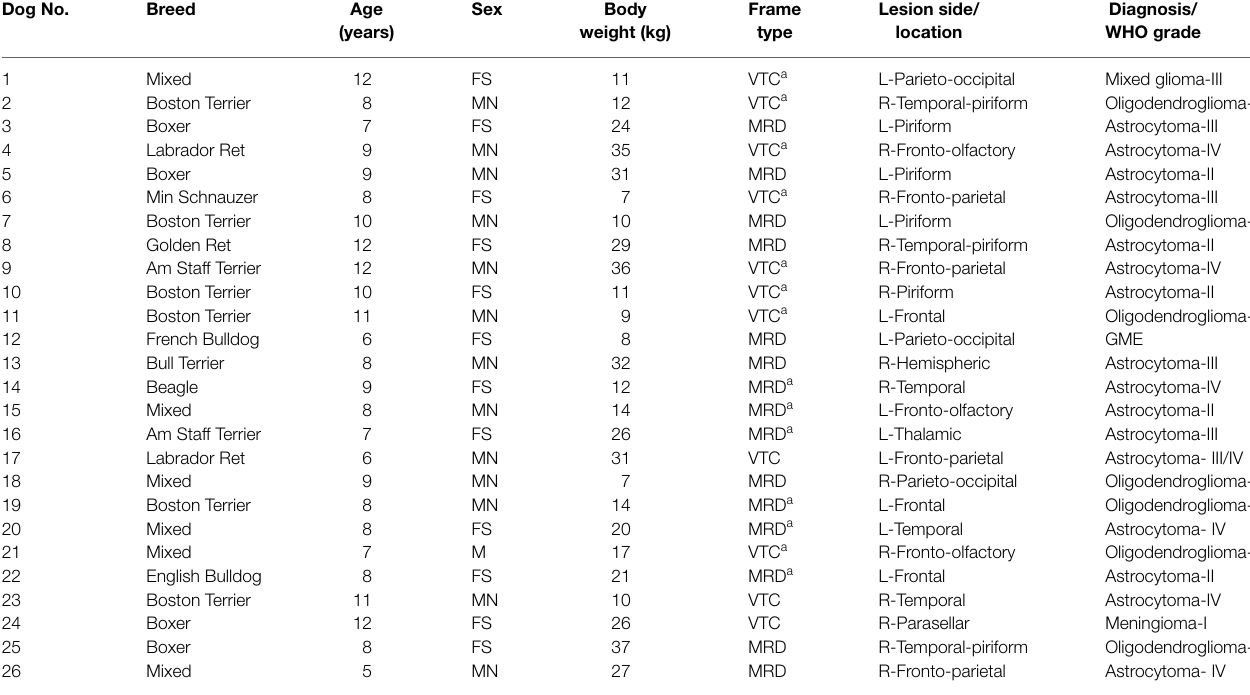
TABLE 1 | Signalments, headframe type, and lesion characteristics of dogs undergoing stereotactic brain biopsy . Dog